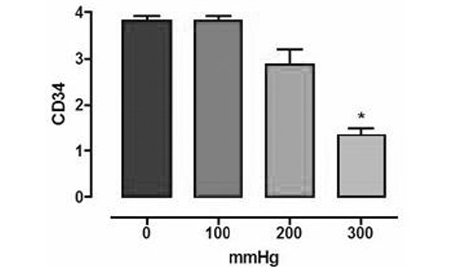
Fig. 1 - Expressão imunohistoquímica do CD 34 (n=20, ANOVA, p<0,05). O asterisco indica diferença estatisticamente significante